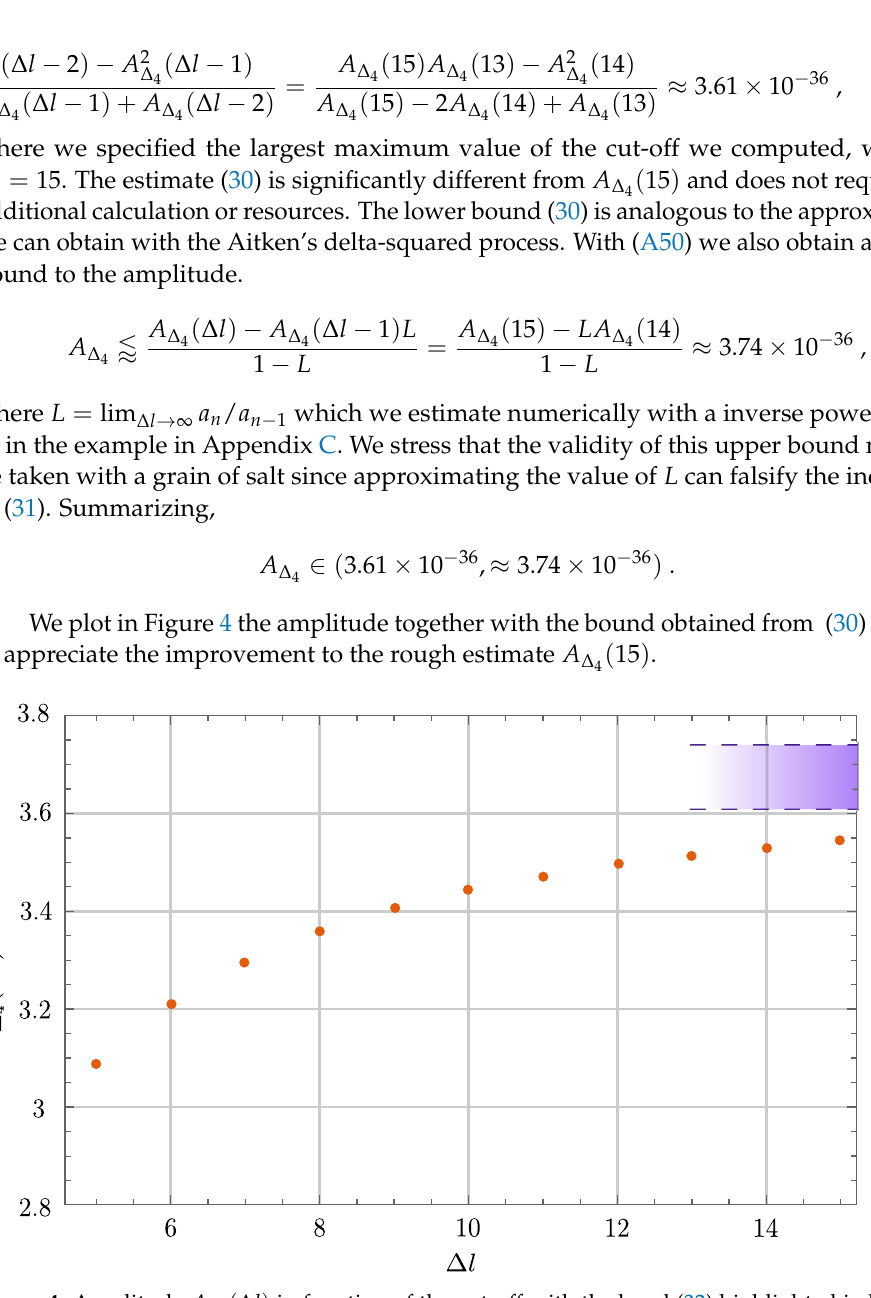
( ∆ l ) in function of the cut-off with the band (32) highlighted in blue. We Figure 4. Amplitude A ∆ 4 excluded the points ∆ l < 5 for a better plot